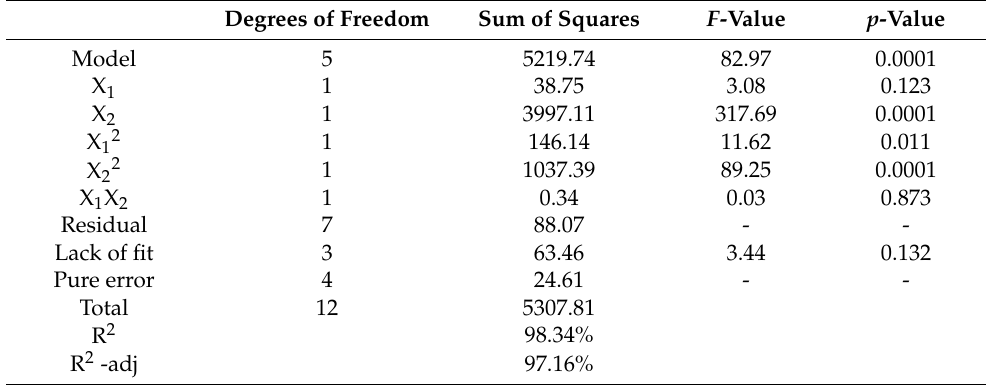
Table 2. Analysis of Variance (ANOVA). Degrees of